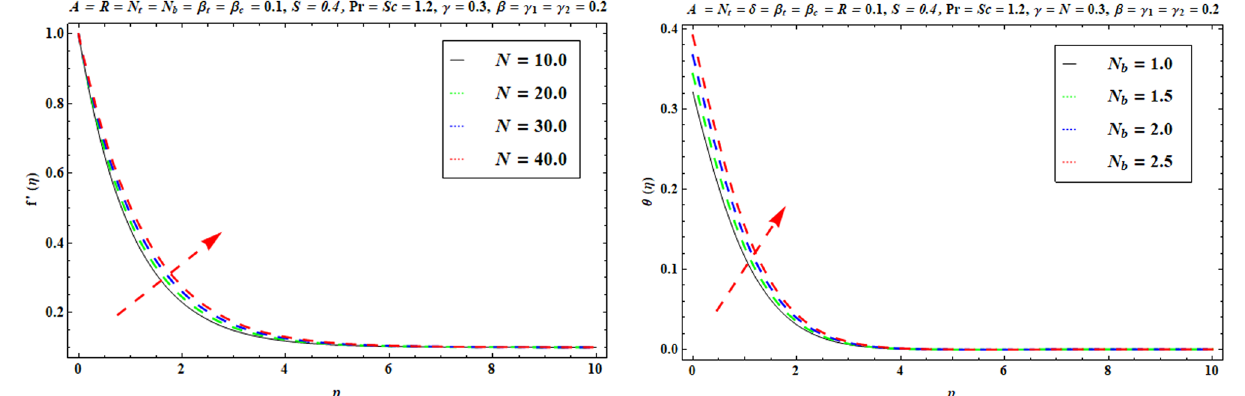
Figure 9: f η ′ ( ) versus N .